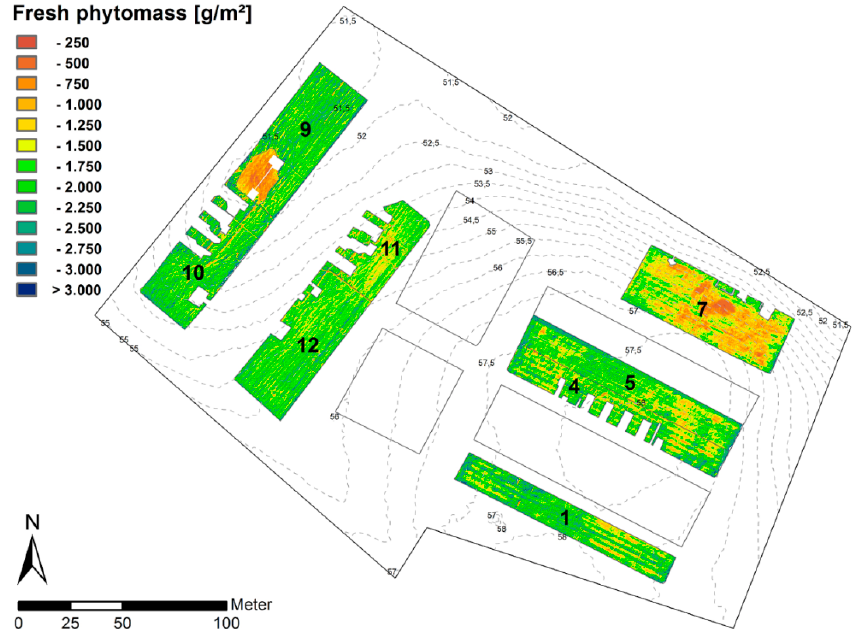
Figure 17. Spatial distribution of fresh phytomass of lucerne within the eight plots of the CarboZALF experimental area. Outclipped areas are disturbed areas due to experimental devices (autochambers, pathways, etc. ).